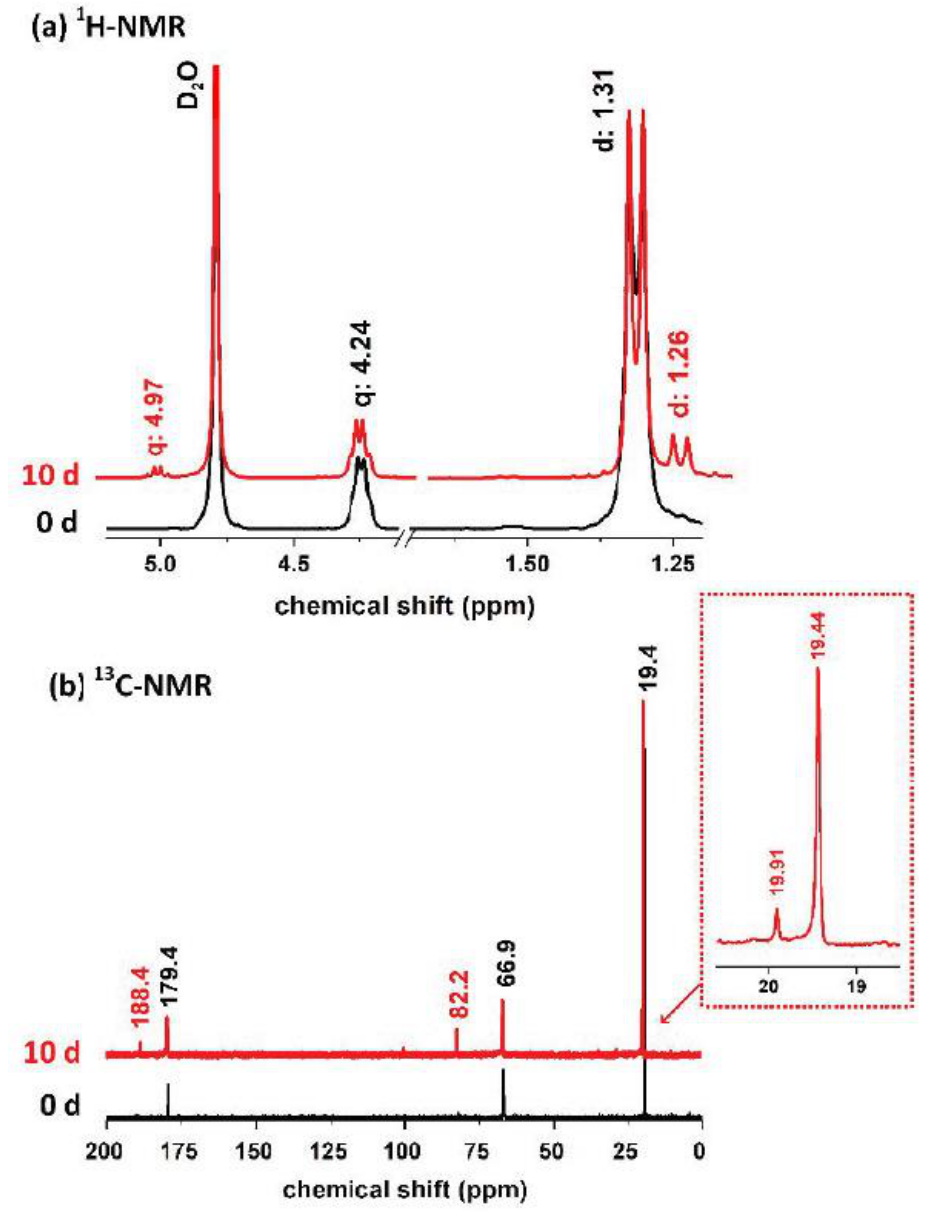
Figure 4. 1 H- ( a ) and 13 C-NMR ( b ) spectra of dissolved degradation products of 2 after 6 h in D 2 O: ( black ) directly measured after dissolution experiment; ( red ) measured after 10 d stored in D 2 O containing an NMR tube. First, only signals for dissolved lactate were detected. After storage for 10 d, the signals for Ti – lactate species were additionally formed.